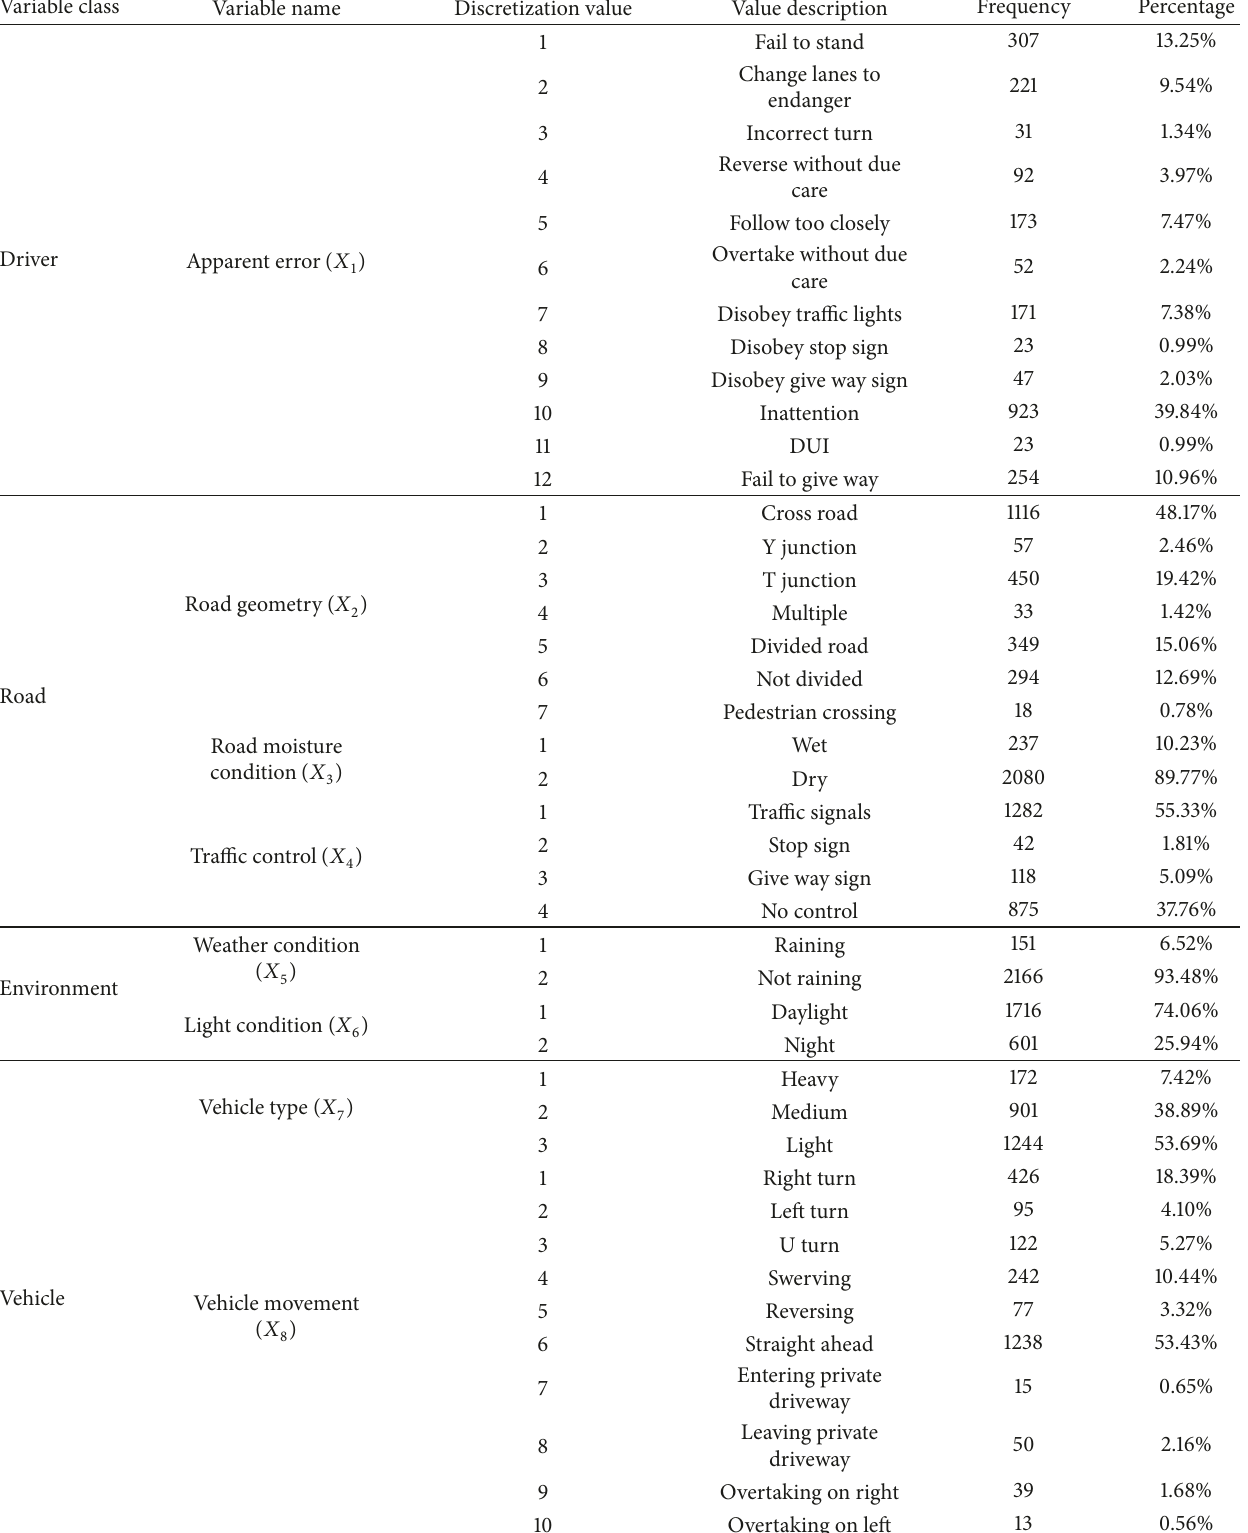
Table 1: Variables of road accidents, Adelaide CBD,